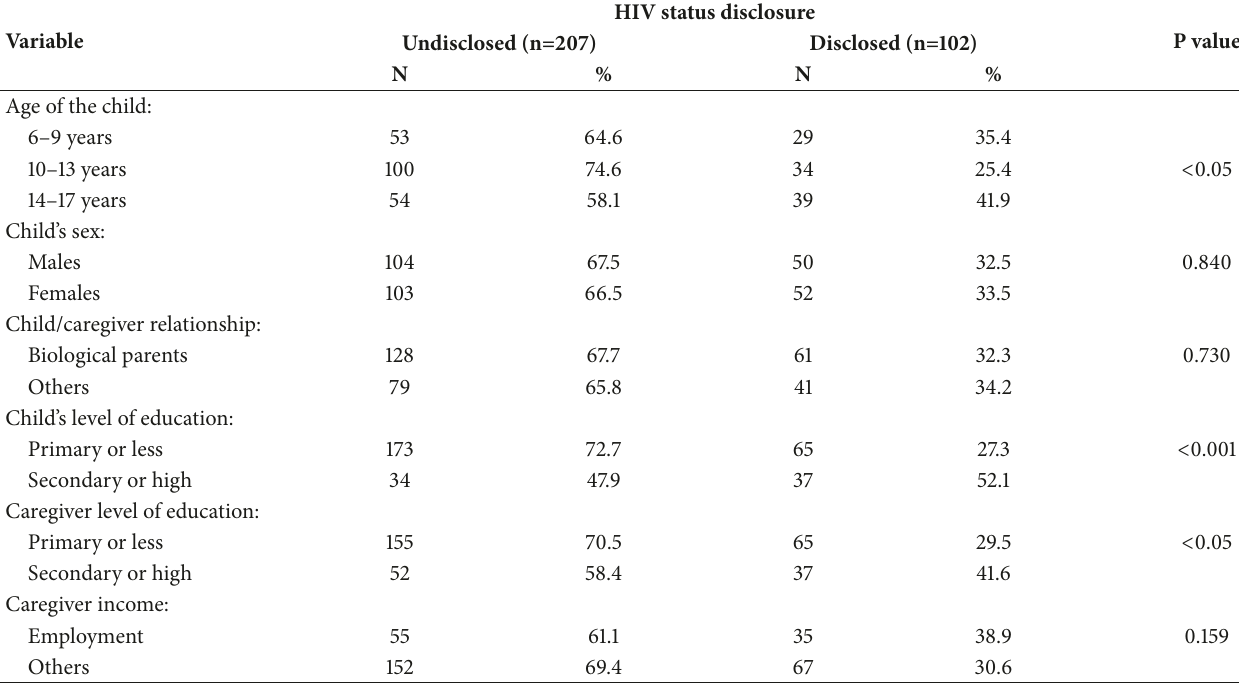
Table 2: Factors related with HIV status disclosure, among children between 6 and 17 years on ART, in Southern Highlands Zone, Tanzania